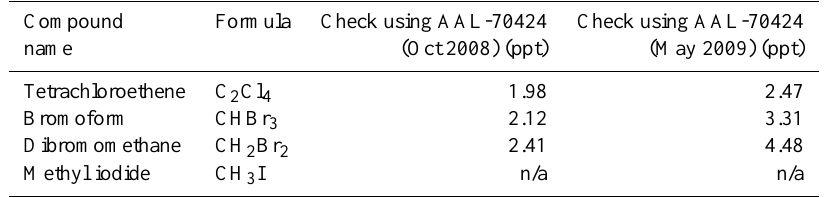
Table 2b. Decanted AAL-70424 used at Bukit Atur (November 2008 to May 2009).